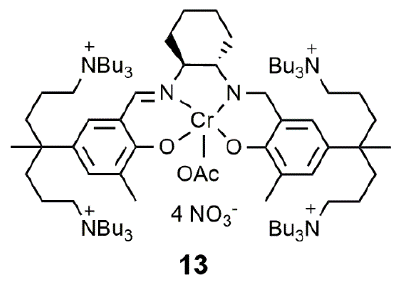
Figure 7. The (salen)Co(III) complex 13 with quaternary ammonium salts in a molecule [31]. This complex displayed one of the highest activities in the CO 2 /PO copolymerization, reaching TOF up to 16,000 h − 1 . In the presence of CO 2 /PO/PA, this complex also shows high reactivity with a total conversion of PO only after 3.0 h ( p CO 2 = 3.5 MPa, T = 80 °C) and a calculated TOF = 12,000 h − 1 . The resulting copolymers have a gradient poly(1,2-propylene carbonate-co-phthalate)s microstructure since, due to the highest reactivity of PA compared to CO 2 , the polymeric chains formed in the initial stages are richer in PA, but the consumption of this comonomer favors the formation of polycarbonate chains in the last stages. The resulting copolymers have a very narrow dispersity ( Đ = 1.03–1.22) and high molecular weight ( M n up to 354 kg mol − 1 ). As previously observed, the incorporation of PA in the polymeric chain enhances the thermal properties of the final polymer with respect to the corresponding PPC. = 1 MPa, T = 80 °C, t = 0.5–6 h) [32]. In the first 2 h, the system only produced the polyester